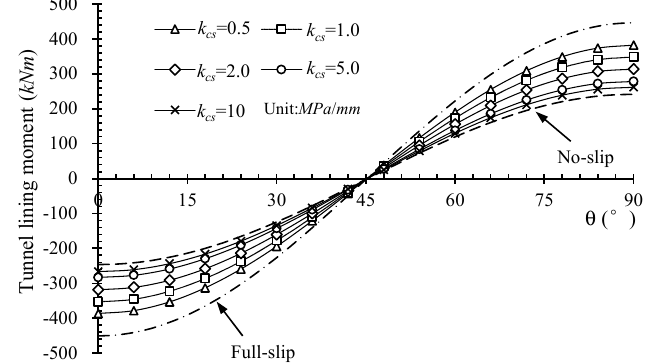
Figure 17. Influence of k cs on tunnel lining moment.